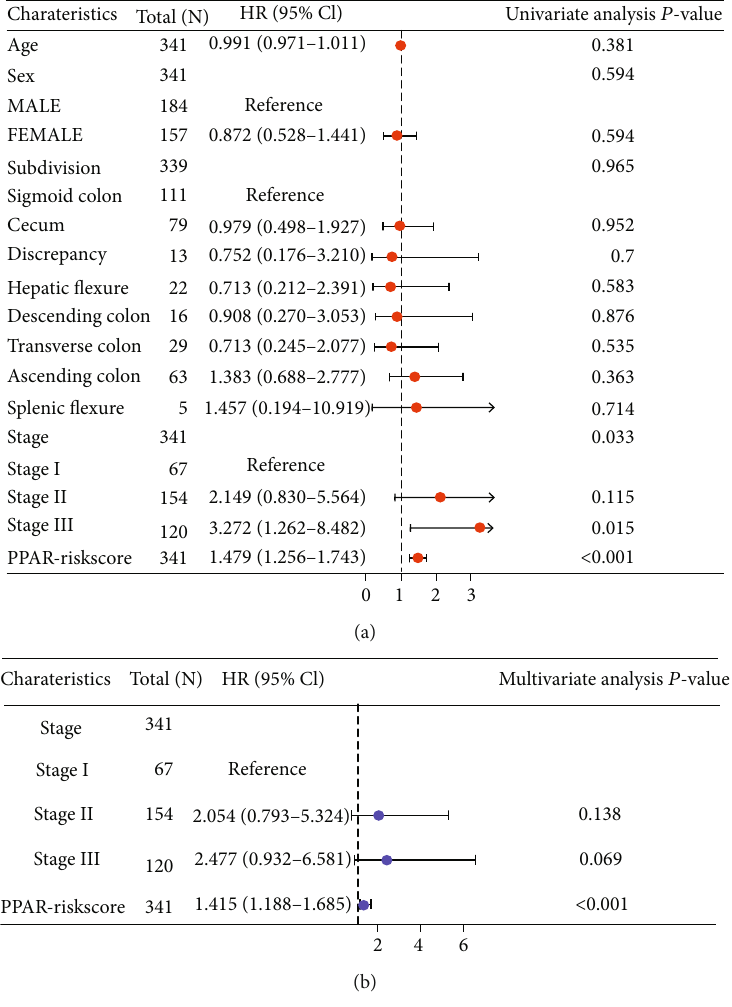
Figure 3: Veri fi cation of the independent prognostic value of the PPAR-Riskscore. (a) Forest plots of the univariate Cox regression analyses among PPAR-Riskscore and clinical factors. (b) Forest plots of the multivariate Cox regression analyses among PPAR-Riskscore and clinical